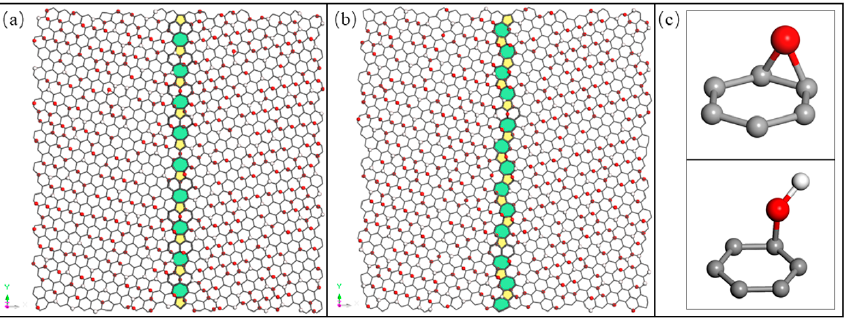
Figure 2. ( a ) PGO model with misorientation angle of 21.8°; ( b ) PGO model with misorientation angle of 30°; ( c ) hydroxyl and epoxy functional groups used in this paper.